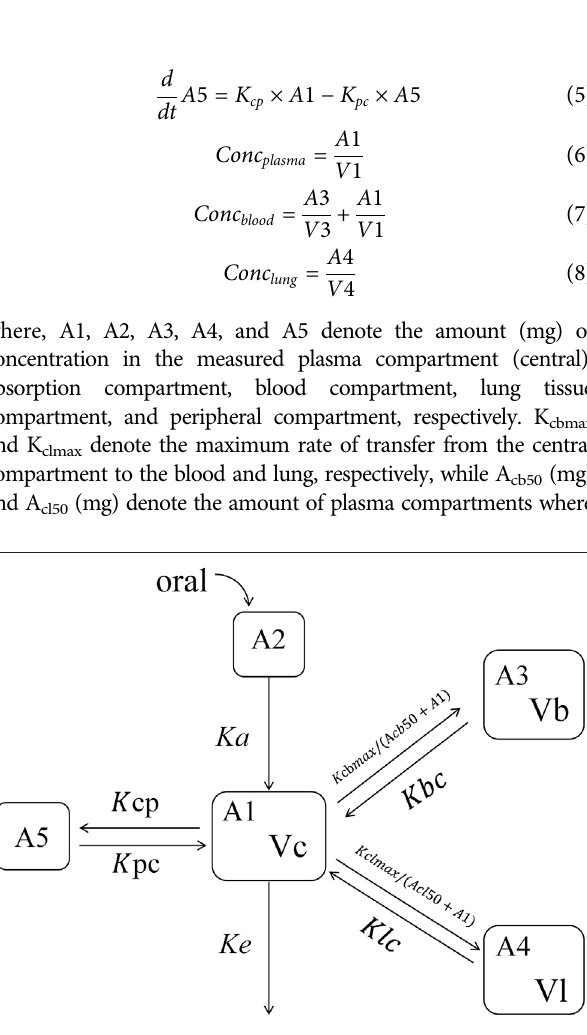
FIGURE 2 | Schematic representation of the pharmacokinetic model used todescribe HCQ concentration – time pro fi les after oral administration. A, amounts; K a , the rate of constant of absorption; K e , the rate of elimination; V c , central volume of distribution; V b , red blood cell volume of distribution; VL, lung volume of distribution; K cbmax , the maximum drug transport rate from the central compartment to red blood cells; K clmax , the maximum drug transportratefromthecentralcompartmenttothelungtissue;A cb50 ,theHCQ amount resulting in 50% of maximum transport rate from the central compartment to red blood cells; K bc , the rate of transport from red blood cells to the central compartment; A cb50 , the HCQ amount resulting in 50% of maximum transport rate from the central compartment to the lung tissue; K lc , the rate of transport from the lung tissue to the central compartment; K pc and K cp , the rate constant between the peripheral compartment and central